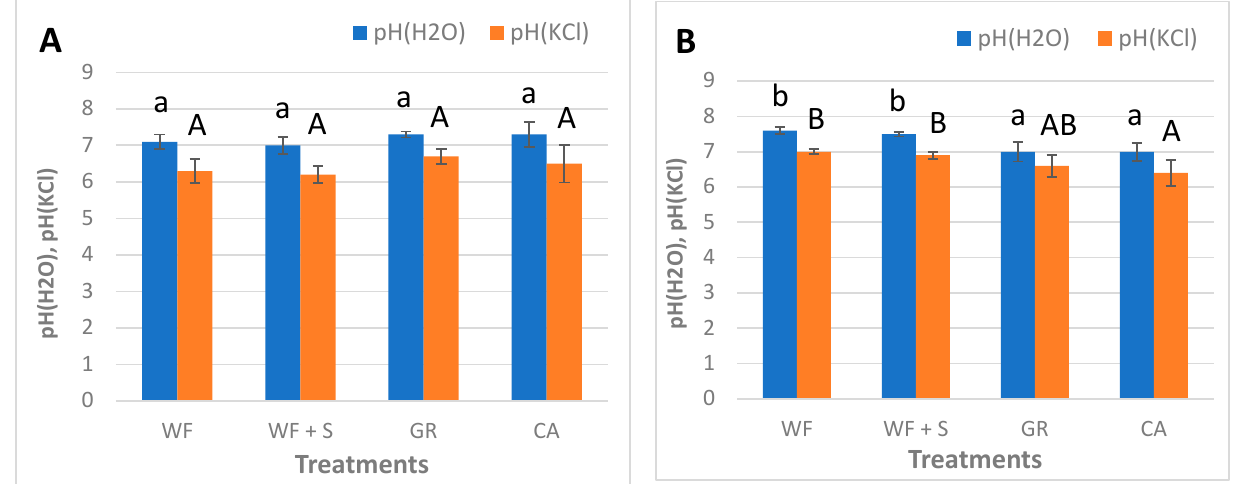
Figure 6. Soil pH values measured in pH(H 2 O) and pH(KCl) in 2018 ( A ) and in 2022 ( B ). Same letters above bars mean no statistical difference. (WF: weed control fabric; WF + S: weed control fabric and straw; GR: grass vegetation; CA: cultivated alfalfa; ˝Osag á rd,